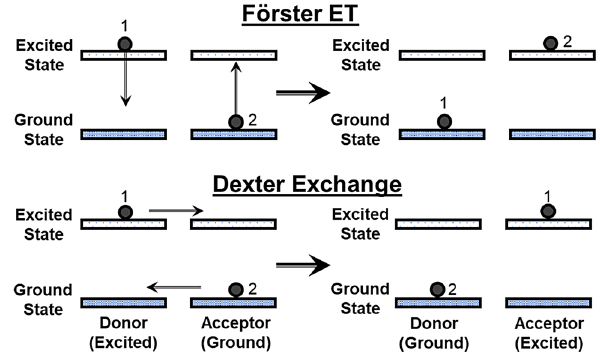
Figure1: IllustrationofFörsterandDexterenergytransferprocesses between a donor and